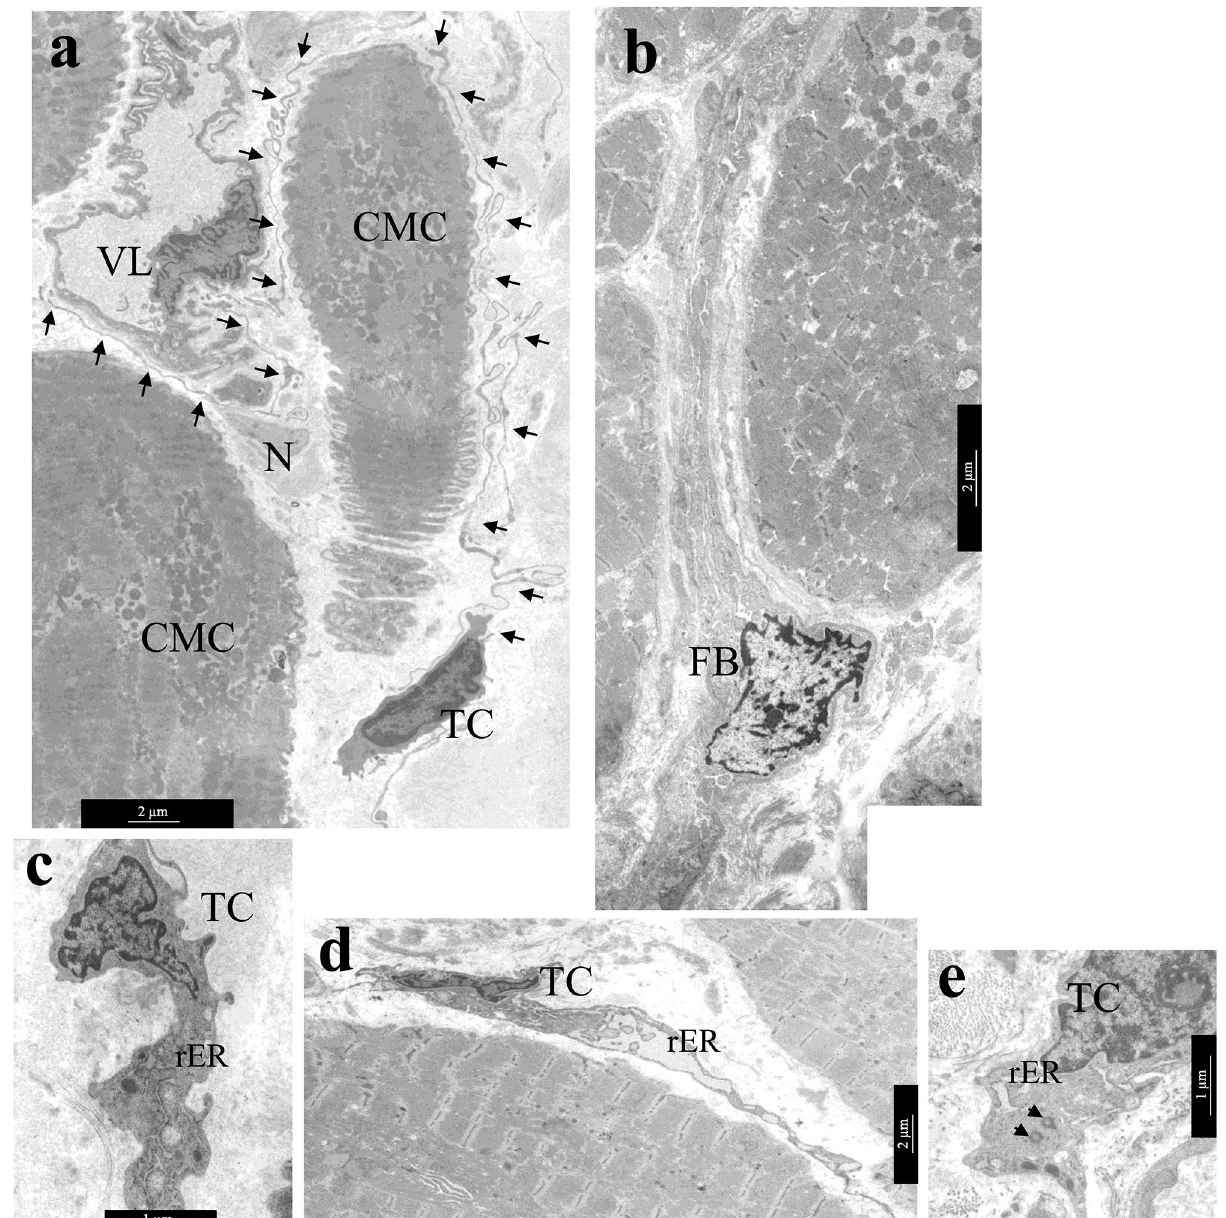
Figure 4. Ultrastructural features of atrial appendage TCs. ( a , b ) Comparison of ultrastructural morphology of TCs and fibroblasts of atrial appendage myocardium. ( a ) Features of TCs morphology: spindle-shaped cells with a small amount of cytoplasm in the perinuclear region, long thin processes (arrows) of TCs surround cardiomyocytes, blood vessels, nerve fibers. ( b ) Features of fibroblast (FB) morphology: star-shaped cells with a large volume of cytoplasm filled with GER tanks, thick processes of fibroblast in the interstitium. ( c ) rER tanks, mitochondria, and electron-dense inclusions in the perinuclear zone of TC cytoplasm. (d ) In some TCs rER tanks are extended, filled with electron transparent contents. ( e ) Two centrioles in the cytoplasm of TC (arrows), rER tanks. ( a , b , e)— bar 2 µm. ( c , d )—bar 1 µm. TEM. TC—telocyte, FB—fibroblast. rER—rough endoplasmic reticulum. CMC—cardiomyocyte. N—nerve fibers. SMC—smooth muscle cells. VL—vessel